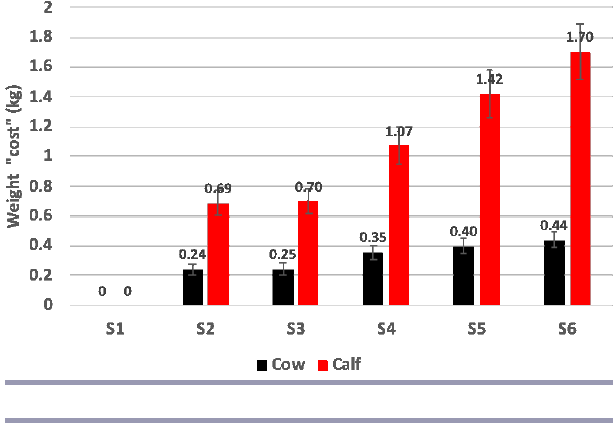
Fig. 6 . The cost to fall cow and calf weights associated with each of the six development scenarios (+ 95 CI).